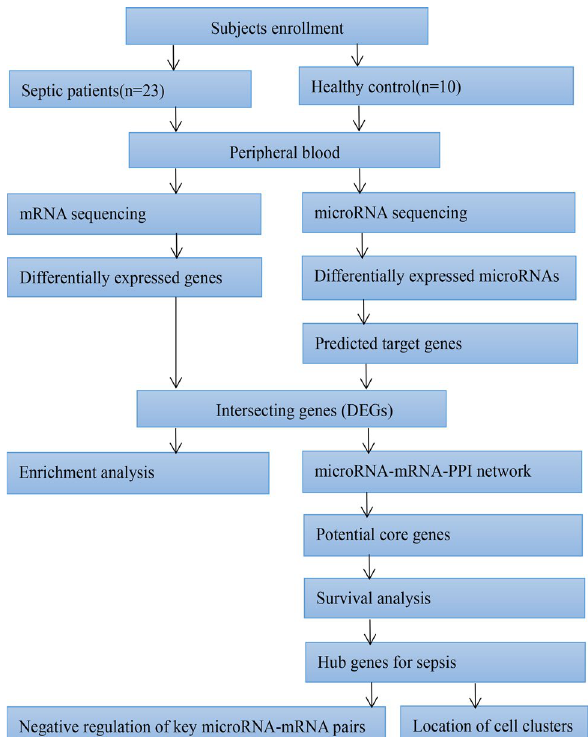
Figure 1. Experimental flow chart of this study. RNA-seq was applied to sequence mRNAs and miRNAs in the peripheral blood of a total of 33 subjects. Combined with bioinformatics, this analysis was used to screen out the key genes and corresponding miRNAs in